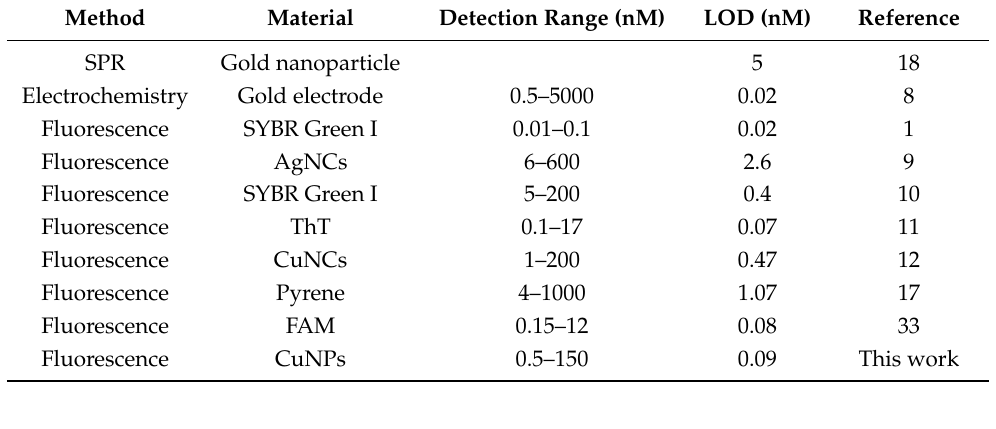
Figure 2. ( A ) Fluorescence emission spectra in the response to different concentrations of SA (0, 0.5, 5, 10, 30, 50, 80, 100, 150, 200, 250, 300, 350 nM) under optimal concentration. ( B ) Fluorescence intensity versus SA concentration at 600 nm and the linear relationship between fluorescence intensities and low concentrations of SA (inset); error bars were estimated from three replicate measurements. Table 1. Comparison of different methods for the determination of SA.